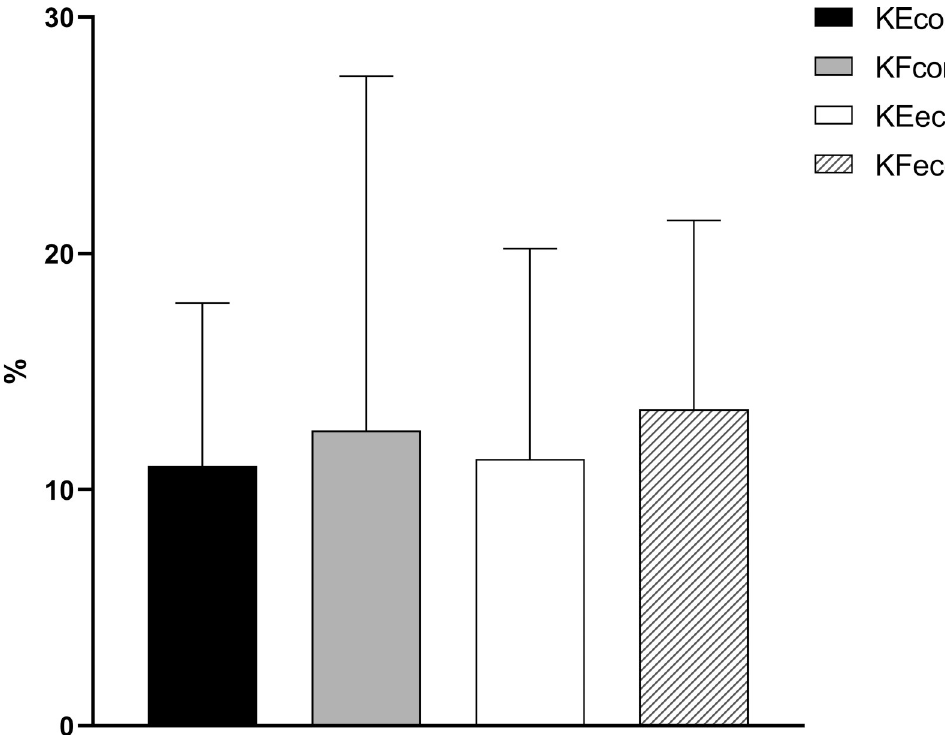
Fig 1. Dominant vs. non-dominant bilateral differences (%) for the knee joint. KE (Knee Extensors); KF (Knee Flexors); con (concentric); ecc (eccentric).